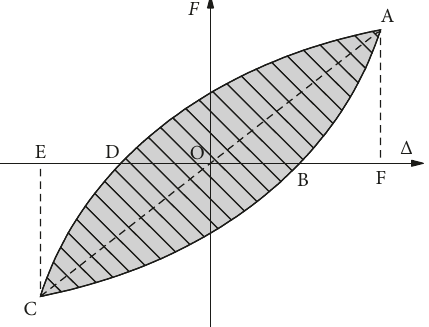
Figure 14: Energy dissipation and equivalent viscous damping ratio.